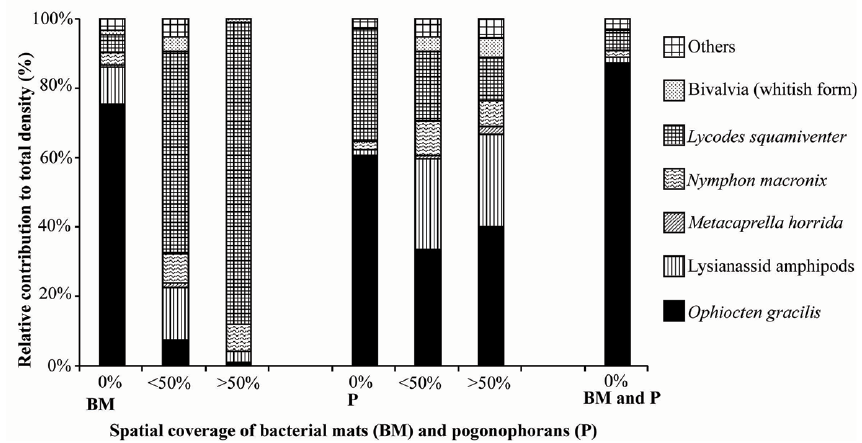
Fig. 6. Relative contribution of the most abundant taxa to total density in areas with different bacterial mat (BM) and pogonophoran (P) cover. Data of three OFOS transects (I, II and III) combined.